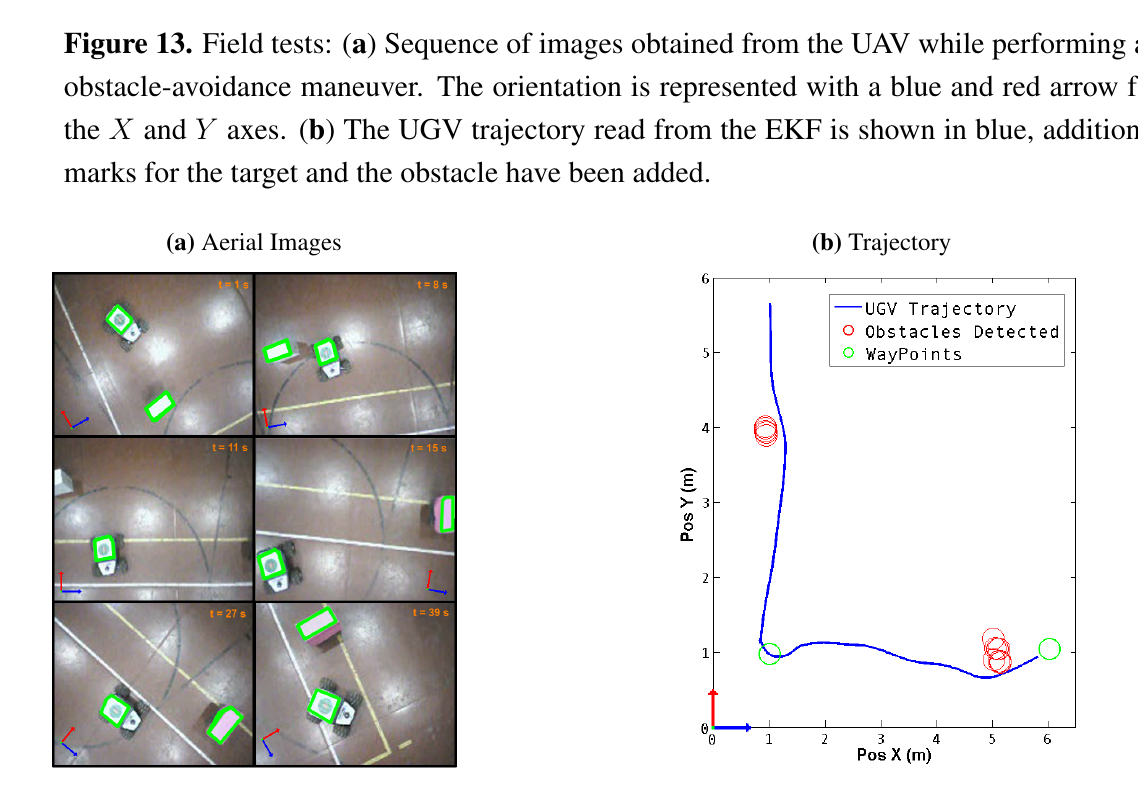
Table 5. Mean Value and Standard Deviation for the obstacles found in the